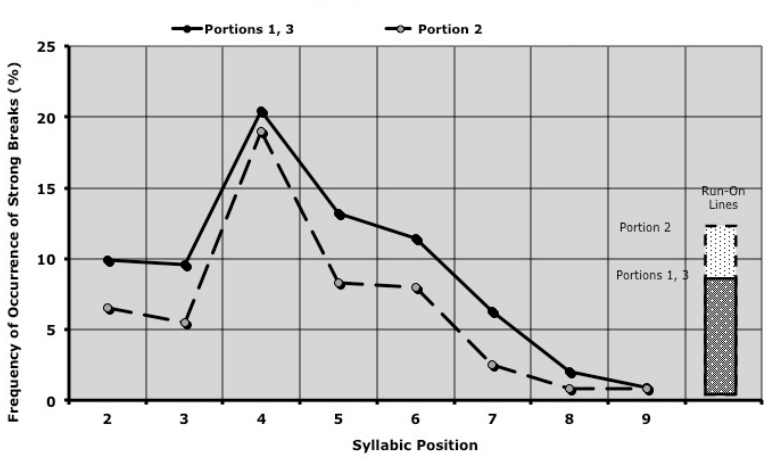
Fig. 4 – Three Portions of Arden of Faversham Strong Syntactic